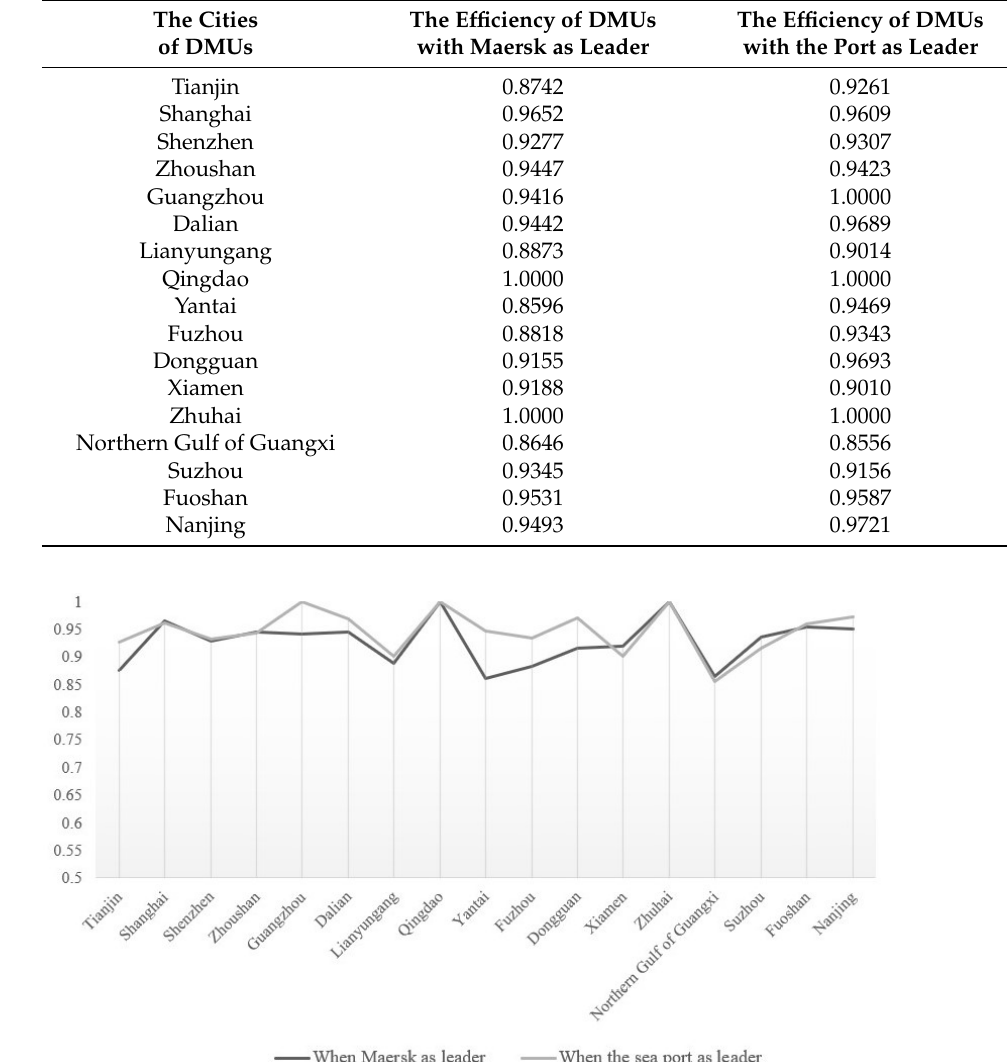
Table 3. The sustainable efficiency of the marine supply chain with different leaders.